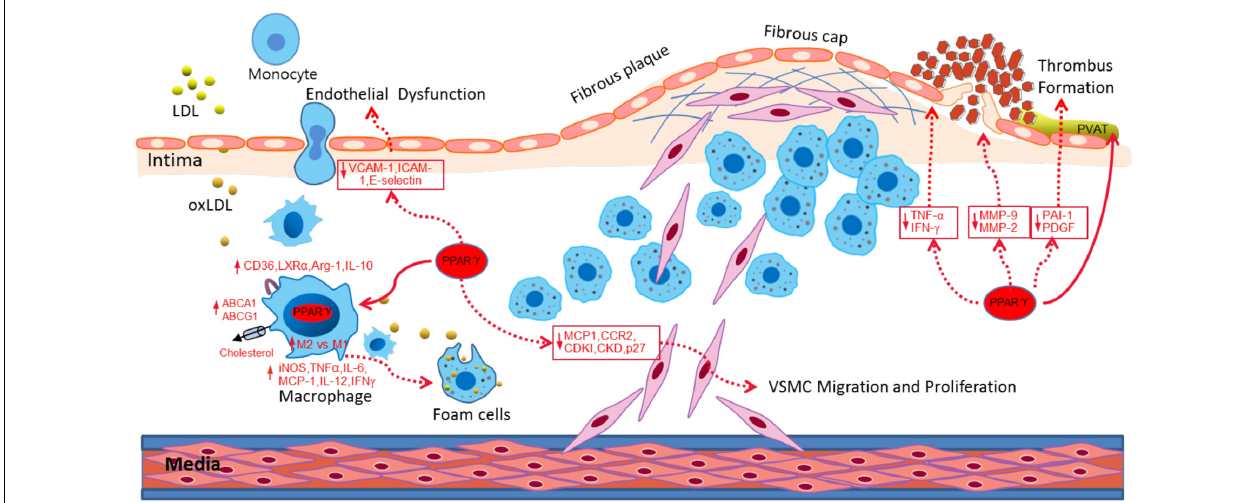
FIGURE 1 | PPAR γ attenuated atherosclerosis through different aspects, including alleviating endothelial dysfunction, promoting cholesterol efflux, inducing M1-M2 transition, inhibiting VSMC migration and proliferation and stabilizing the fibrous cap and